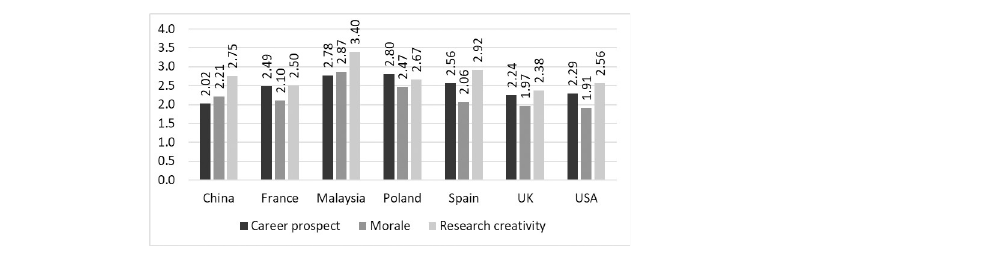
Fig 2. Country differences for overall